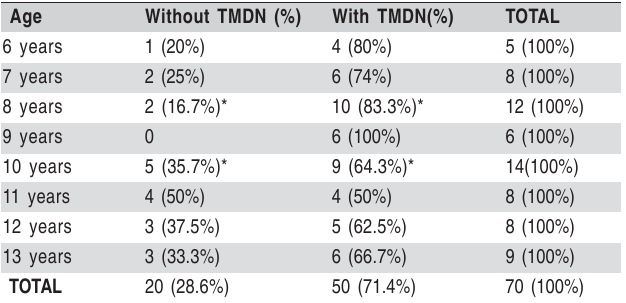
Table 2. Number and percentage of participants with and without TMD according to age